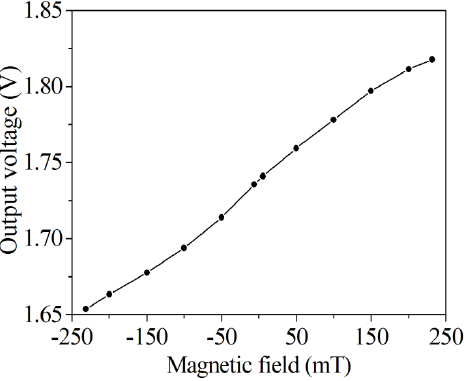
Figure 13. Relation between output voltage and magnetic field for the magnetic sensor.